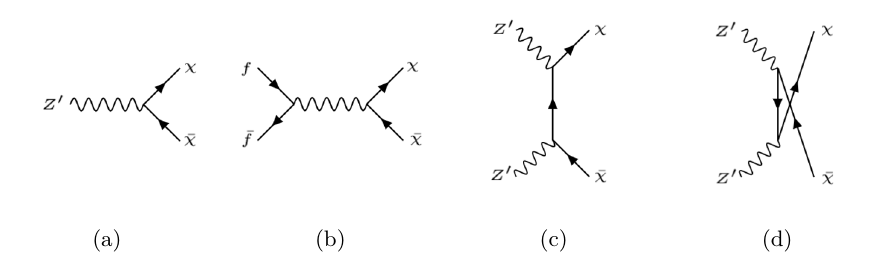
Figure 1. The Feynman diagrams for the DM production processes in our model: Z 0 decays (a), SM fermion annihilations through s-channel exchange of Z 0 (b), and Z 0 annihilations through t and u-channel exchanges of χ